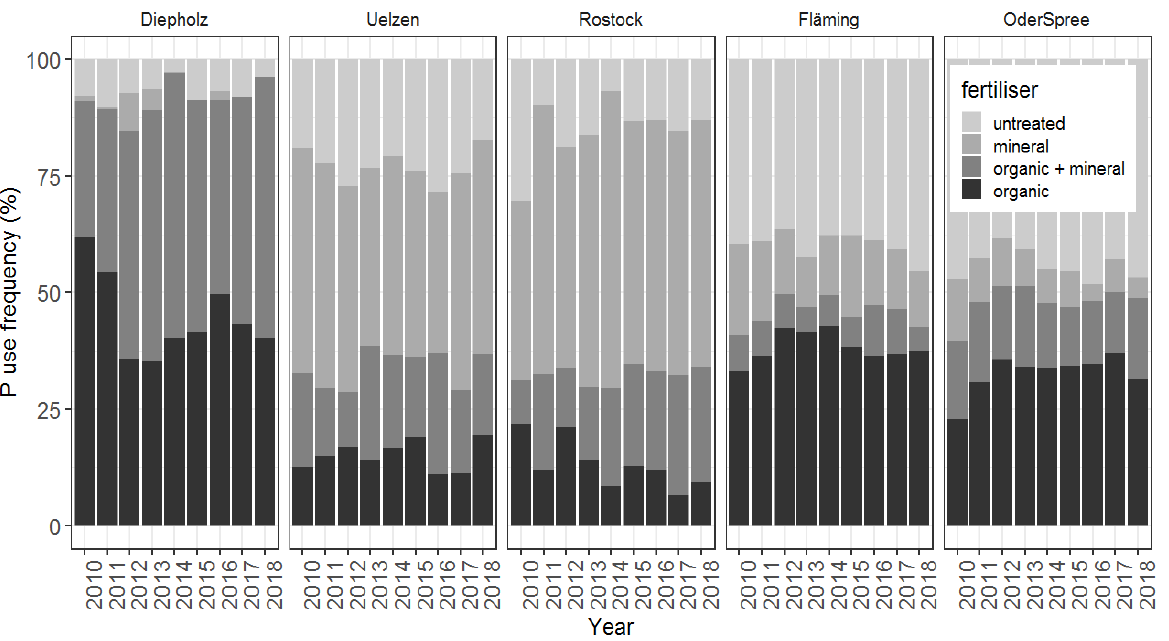
Figure 4. Indicator frequency of P fertiliser used on the whole area displayed for untreated, mineral only, organic and mineral, and organic only treatment per region (Diepholz, Uelzen, Rostock, Fläming and Oder-Spree). Each farm contributes one value per year per treatment group to the total of the region (see Section 2.4). Numbers are given in Appendix B (Table A2). Table 3. Explained variance (%) of the explanatory variables (farm, year and region) for the frequency at which P is used. The nested factor given in brackets means the farms are nested in the region. Analysis performed with a balanced study sample (n = 450). Totals above 100 are due to